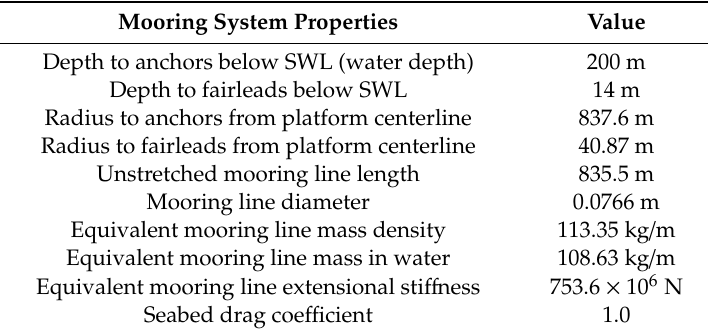
Table 3. Key properties of mooring lines in